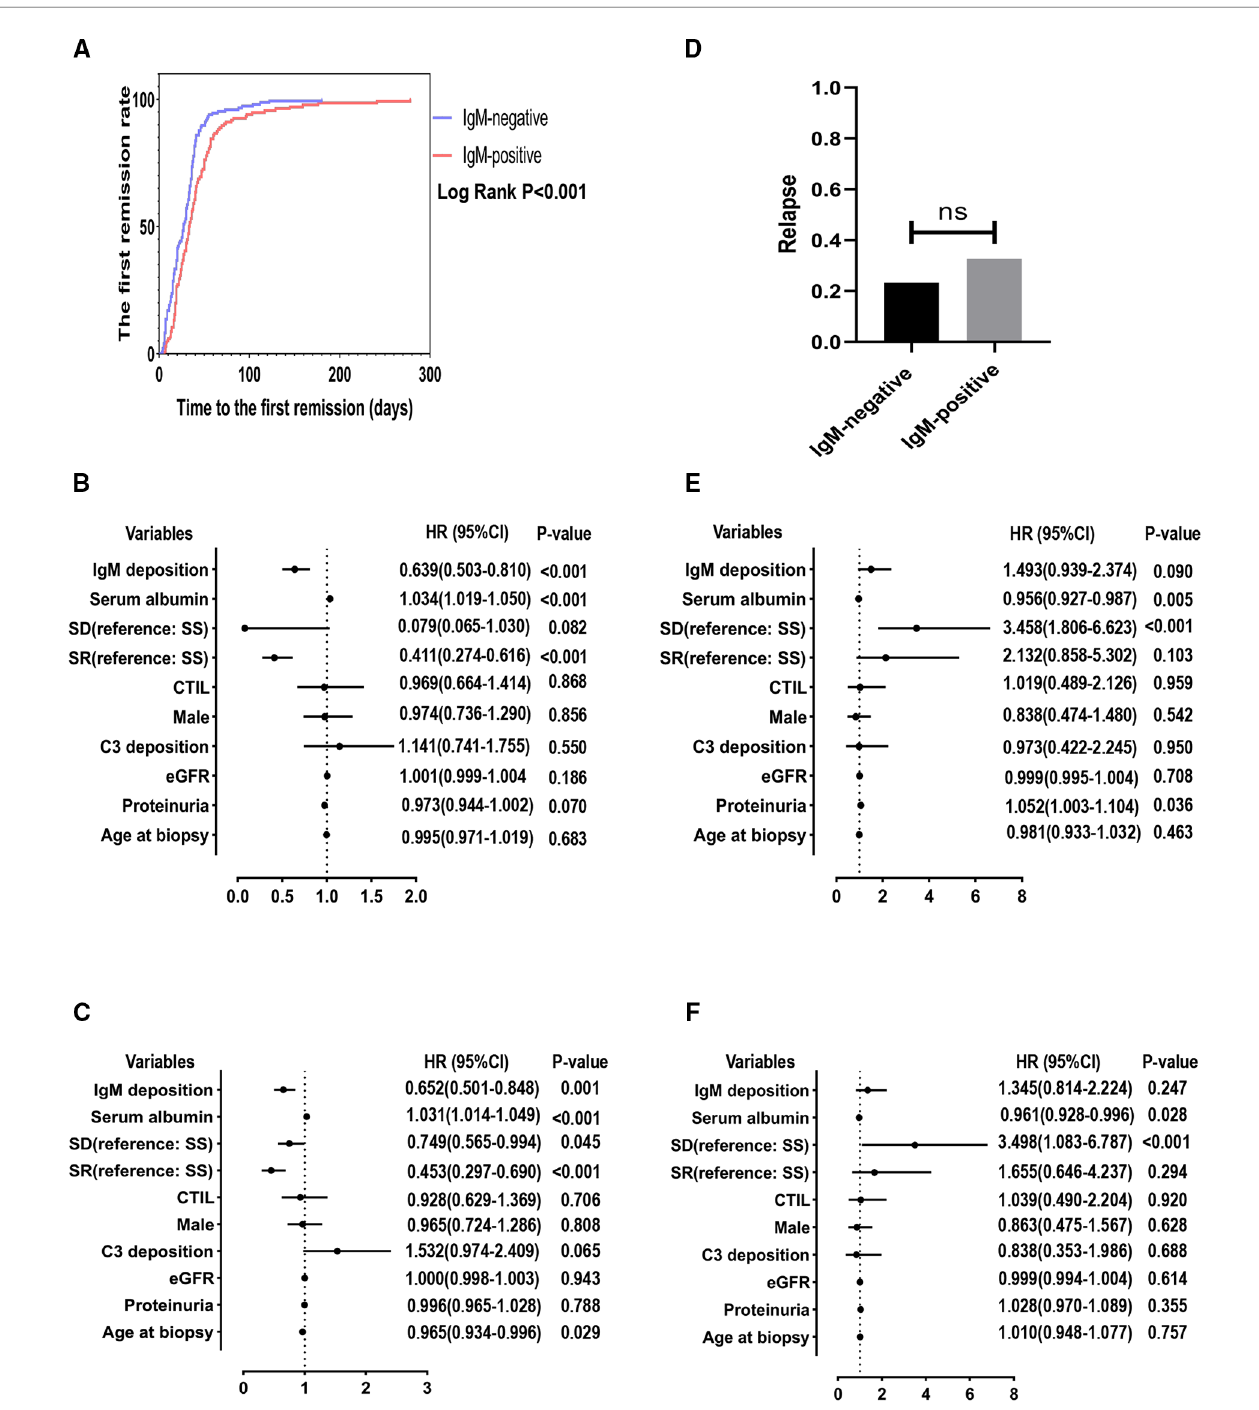
FIGURE 2 The minimum follow-up was 6 months. SD, steroid-dependent; SR, steroid-resistant; SS, steroid-sensitive; eGFR, estimated glomerular fi ltration rate; CTI, chronic tubulointerstitial injury. ( A ) Cumulative rate of the fi rst remission. ( B ) Independent predictors of the fi rst remission by univariate cox regression analysis. ( C ) Independent predictors of the fi rst remission by multivariate cox regression analysis. ( D ) Comparison of the number of recurrences between the two groups. ( E ) Independent predictors of the fi rst relapse by univariate cox regression analysis. ( F ) Independent predictors of the fi rst relapse by multivariate cox regression